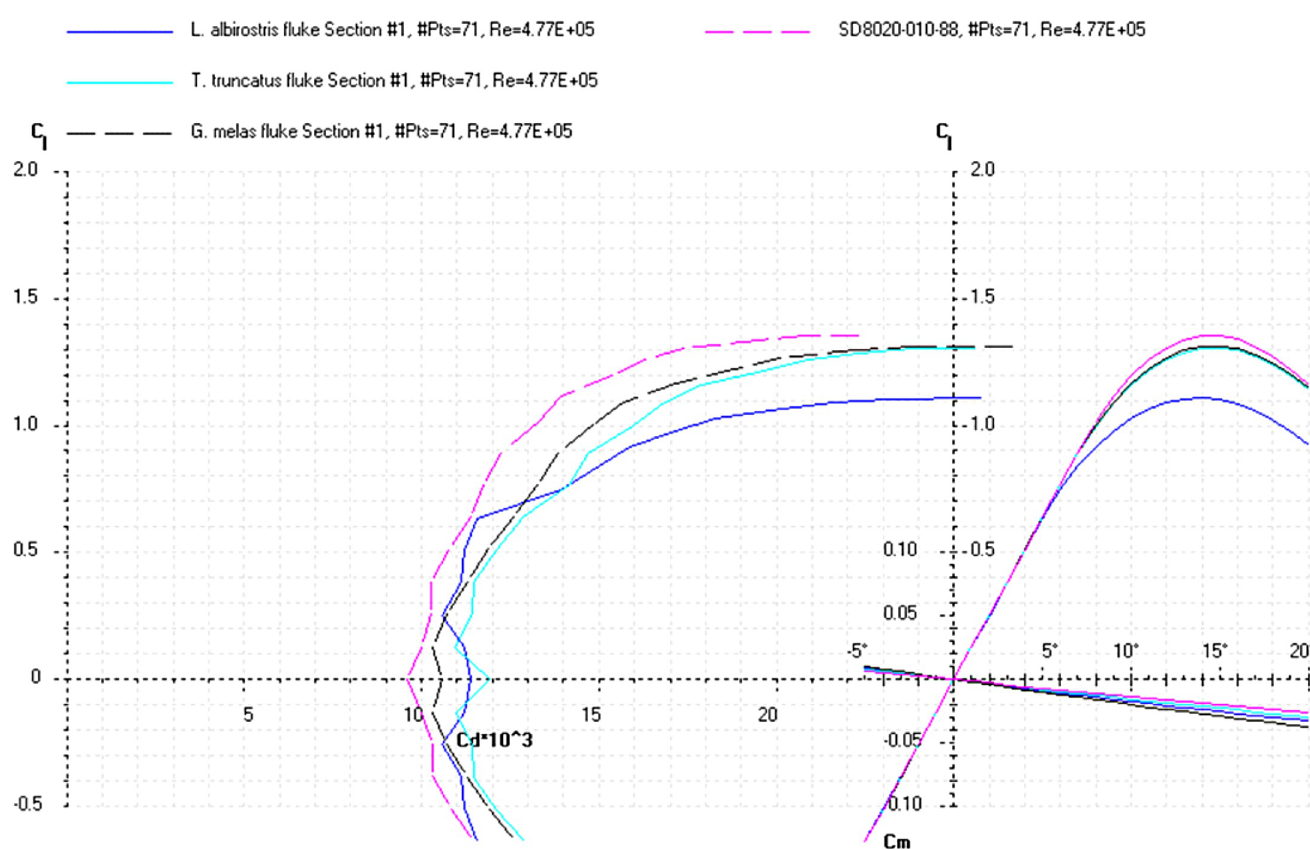
Fig 16. Drag polar diagram of lift CL vs drag Cd. Calculated for the cross-sections taken at the base of the tail flukes of the L . albirostris , T . truncatus , G . melas and SD8020 airfoil at the averaged Re 4.77E+05 for the fluke’s cross-sections (Table 10).